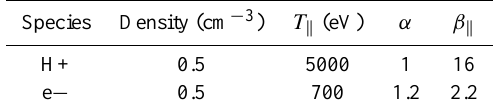
Table 3. Plasma model 3 corresponding to the period between 02:25 and 02:32UT closer to the equator with B 0 =